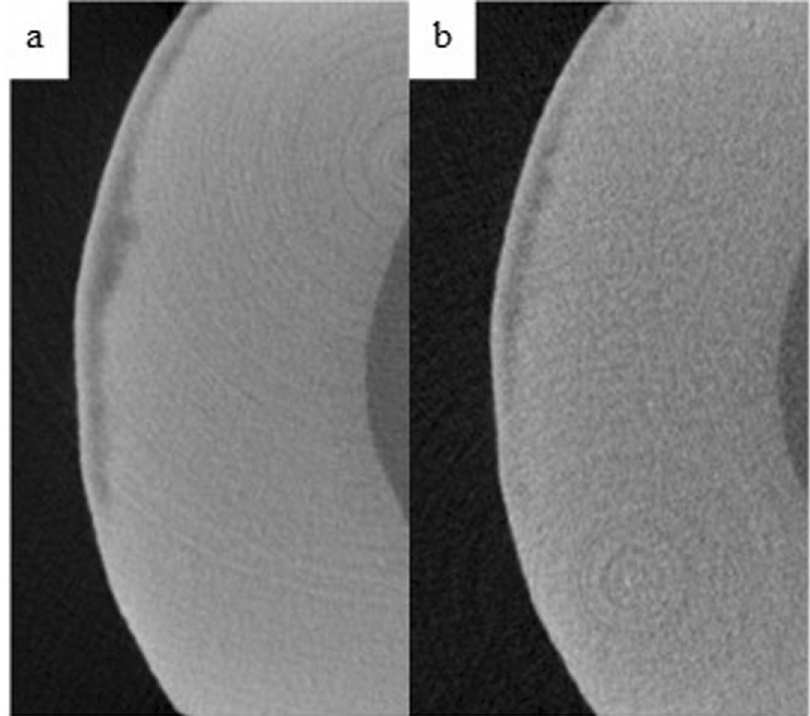
Fig. 4 Remineralization of etched enamel MIH lesions with 1450 ppm NaF toothpaste. Representative µ-CT images of etched enamel MIH lesions, before ( a ) and after ( b ) in-situ